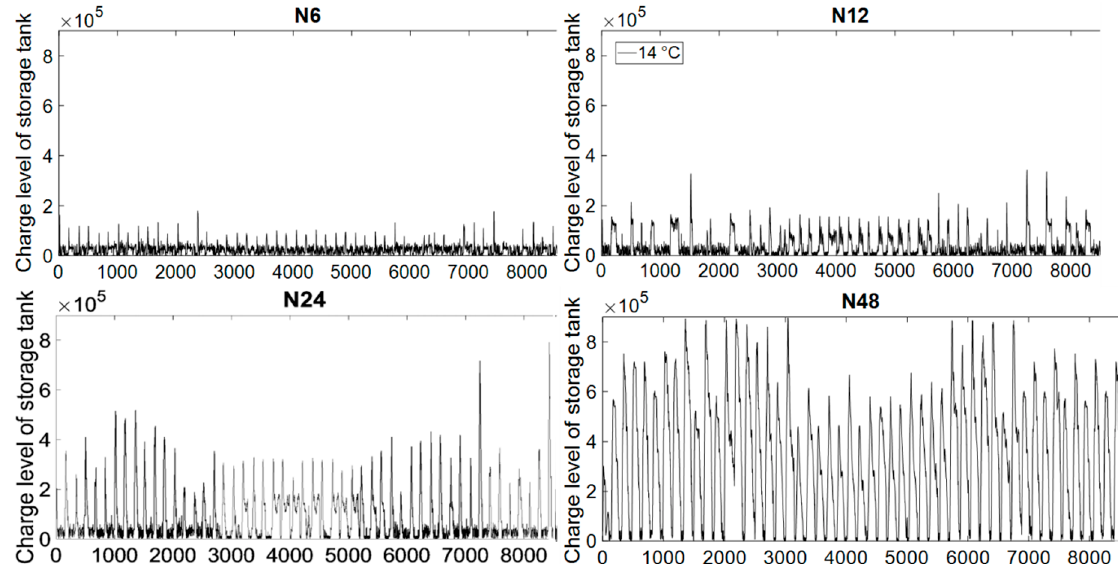
Figure 7. Charge level of the storage tank for varying prediction horizons .